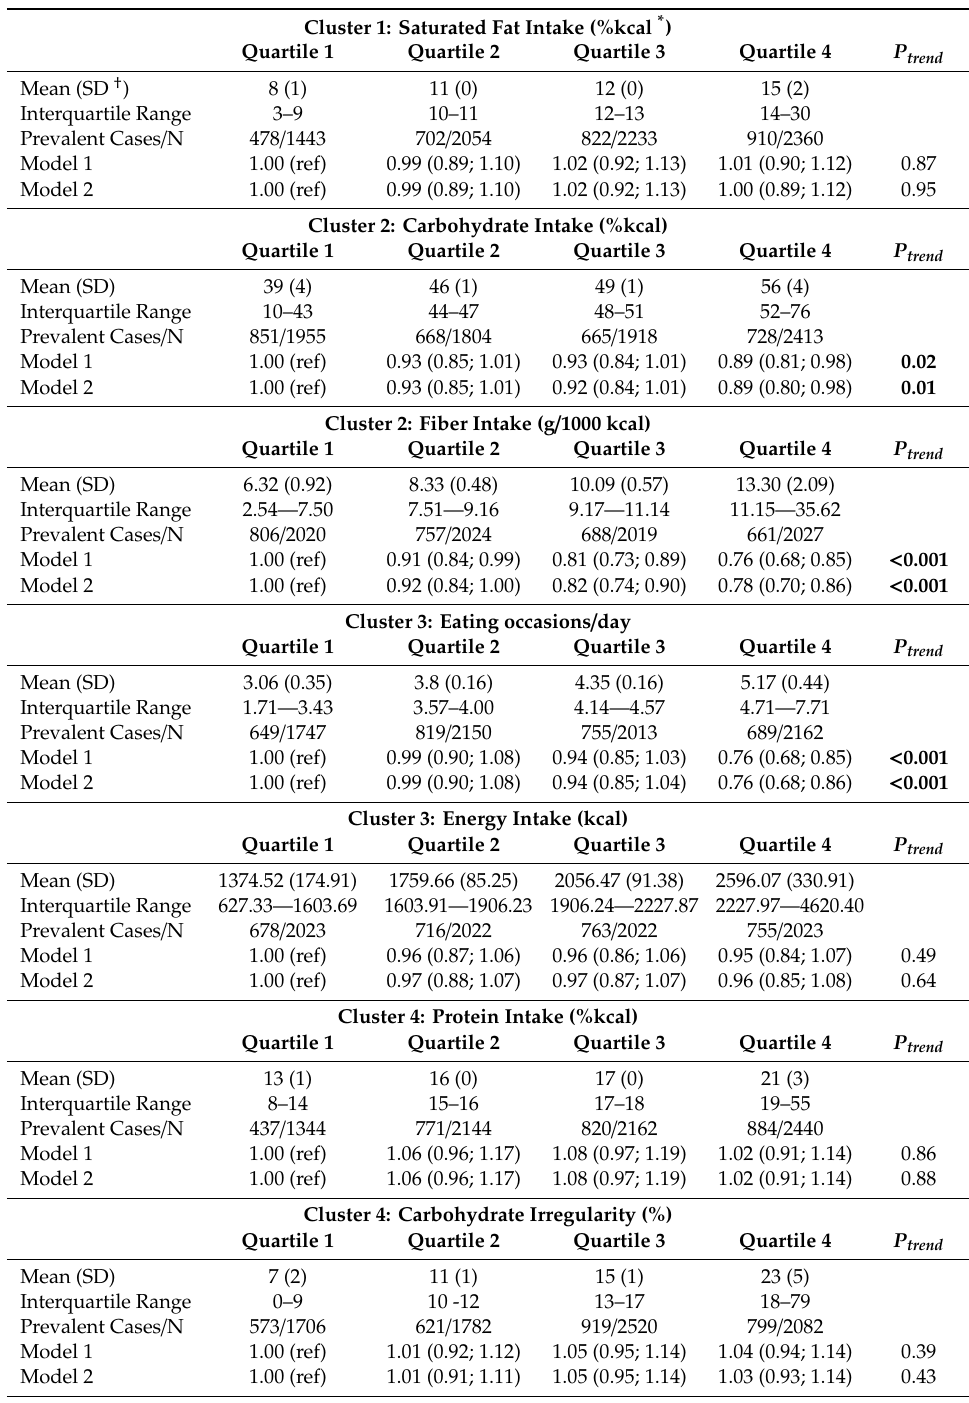
Table 3. Cross-sectional associations between k-means four-cluster solution top hit diet exposure quartiles with cardiometabolic risk prevalence ( N = 8090). Values are presented as prevalence ratio (95% confidence interval). Significant p-values ( p < 0.05) are marked in